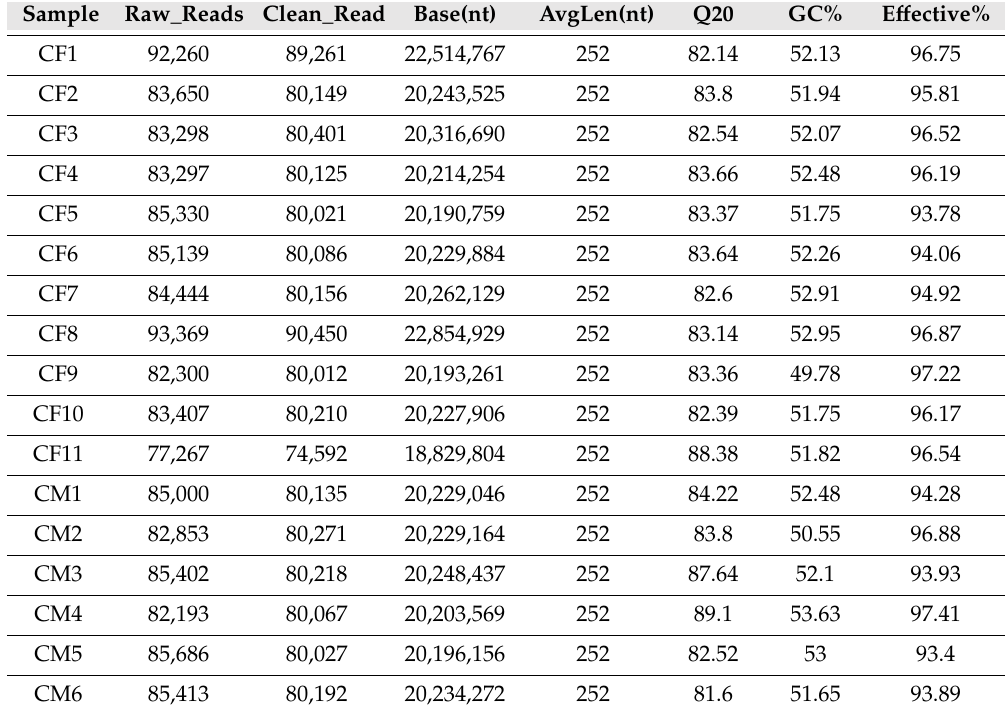
Table 1. Data preprocessing statistics and quality control